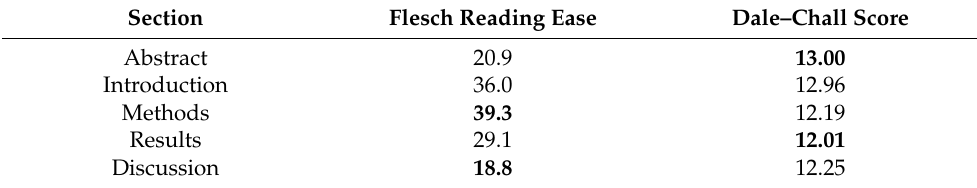
Table 9. Average readability scores of different sections of papers published in Remote Sensing